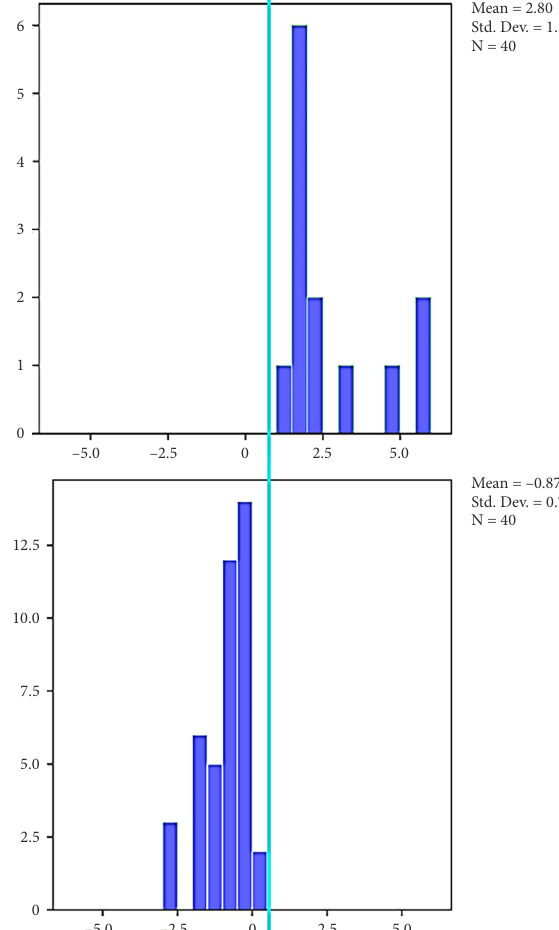
Figure 1. Histograms of groups (source: authors’ processing)